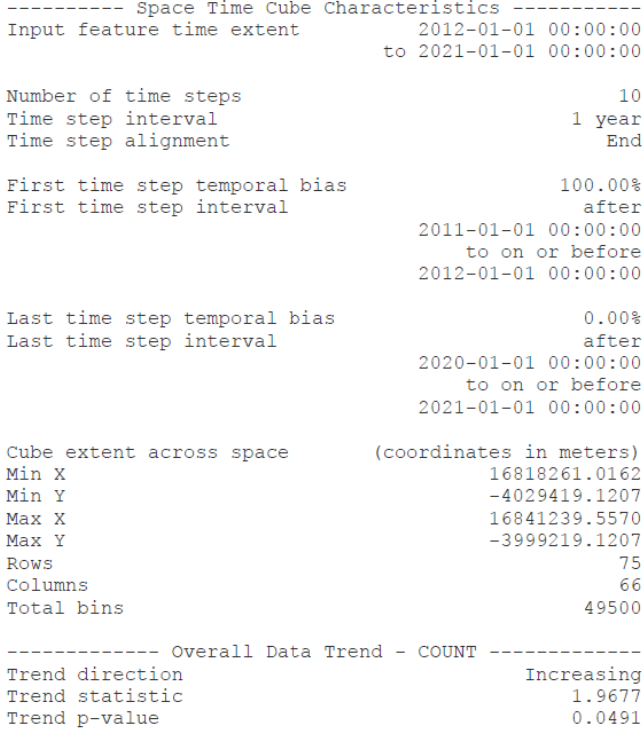
Figure A4. On-premises licence space-time cube logfile.